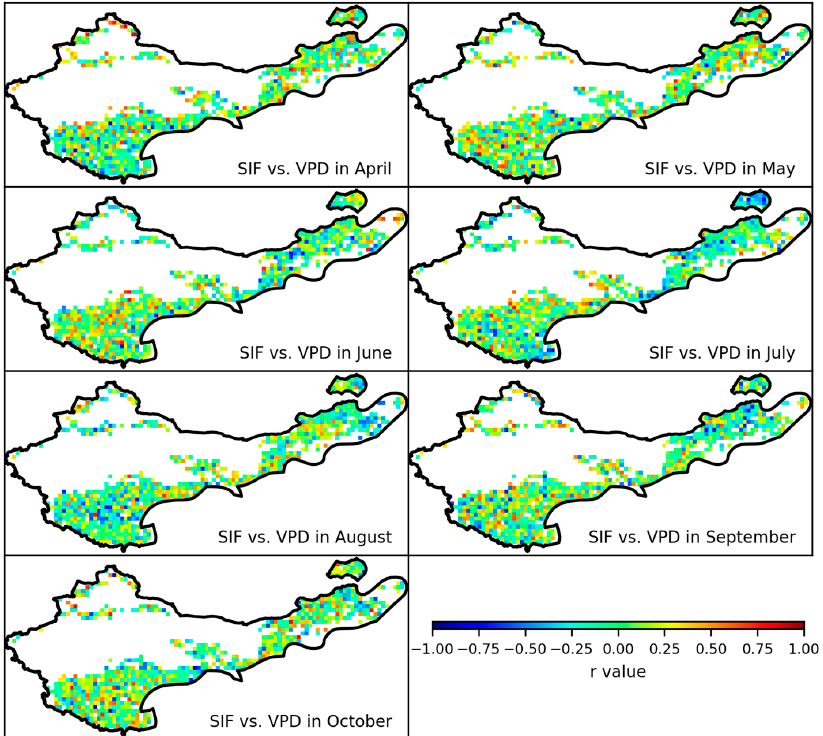
Figure 7. Spatiotemporal distribution of the correlation coefficients between SIF and TCI in each month of growing season. Pixels with white color mean non-grassland or missing data. ISPRS Int. J. Geo-Inf. 2020 , 9 , x FOR PEER REVIEW